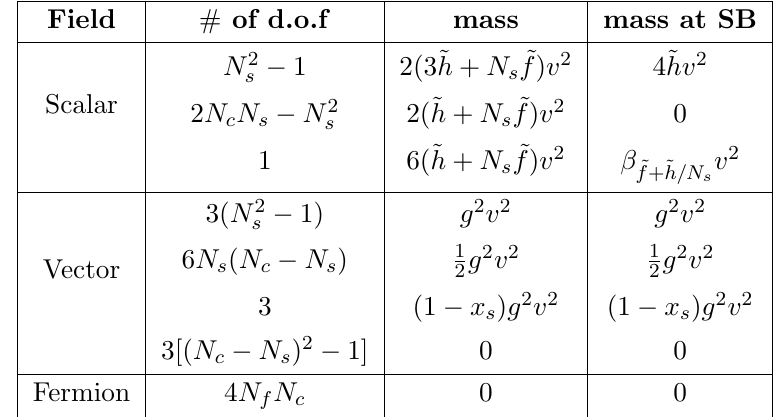
Table 1 . Field content and mass spectrum of the model. In the second column, we indicate the number of degrees of freedom of each species, in the third we give the general form of the mass after symmetry breaking and in the fourth we give the mass expected at the symmetry breaking